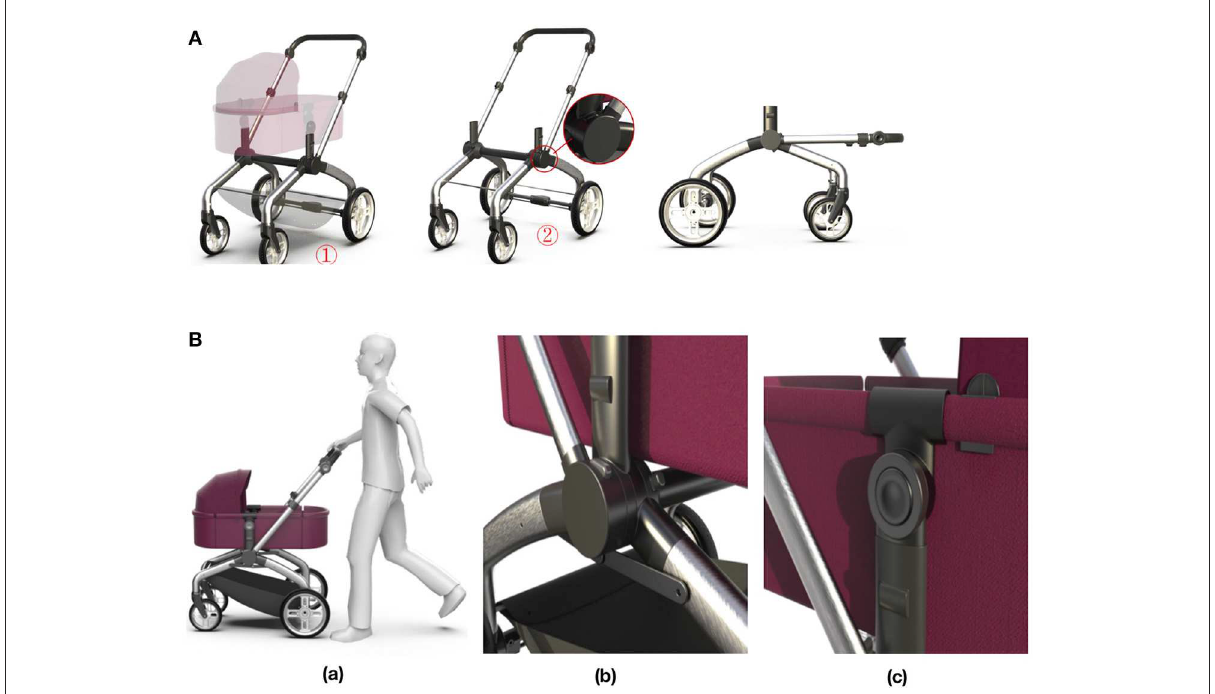
FIGURE6 (A) Baby walker mode. ‹ Remove the storage basket and sleeping basket. › Press the rotating button of the rotating handle to adjust to the appropriate position. (B) Baby stroller mode. (a) Baby stroller mode. (b) Middle connecting device. (c) Sleeping basket connector.